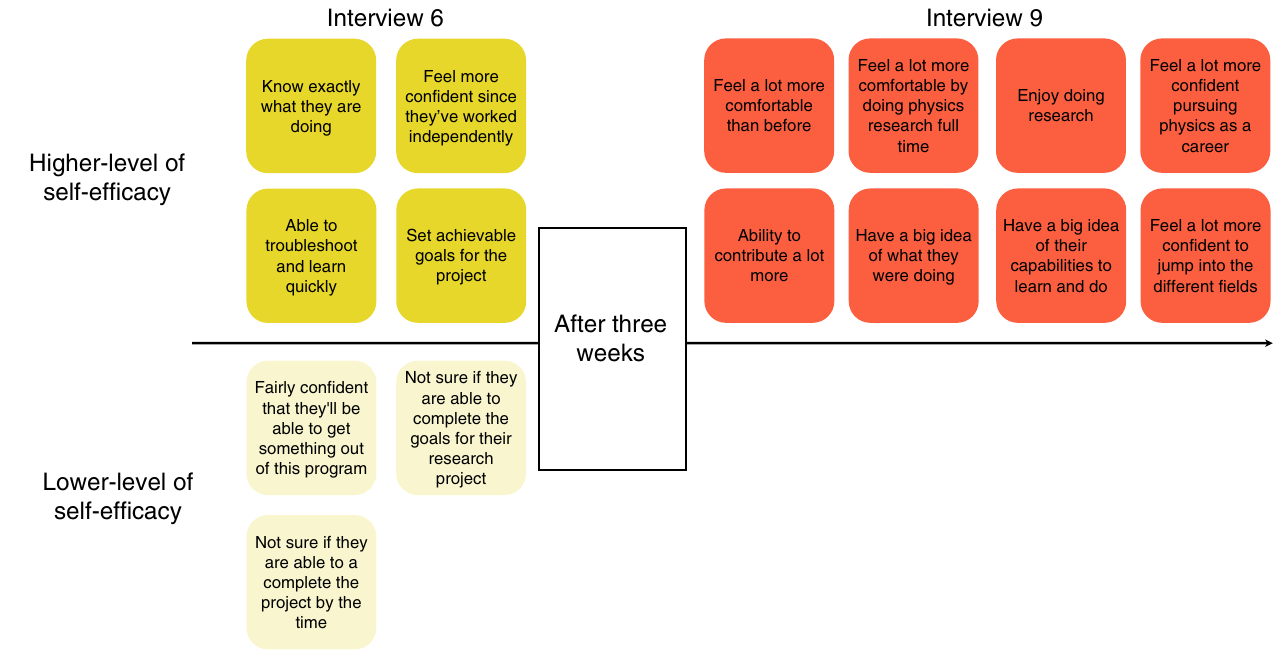
FIG. 3. A representation of the growth in mentees ’ self-efficacy. The areas shaded in a lighter color denote the lower level of self- efficacy while the areas shaded in a darker color denote the higher level of self-efficacy. The text in the boxes are paraphrases of mentees ’